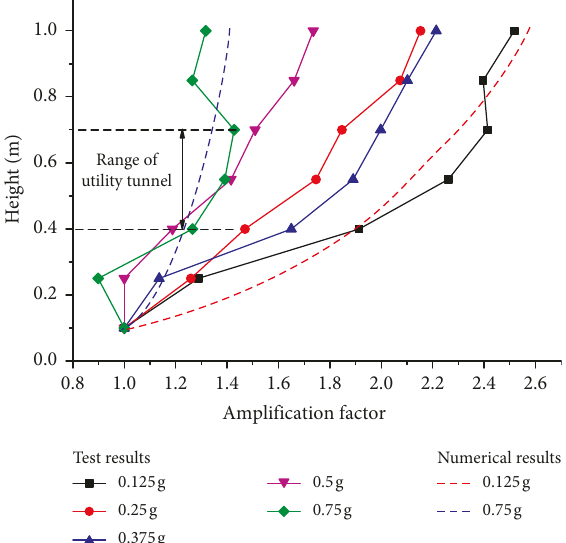
Figure 11: Acceleration amplification factors of model soil.